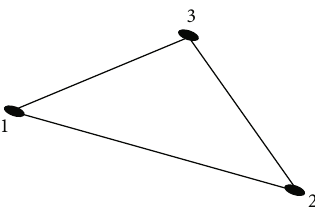
Figure 4: Approximate space for pressure and concentration.